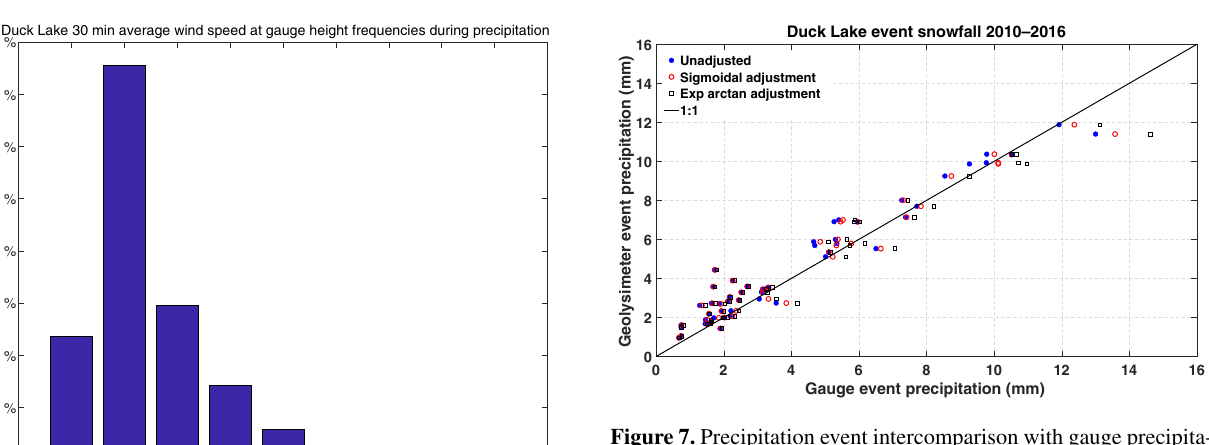
Figure 7. Precipitation event intercomparison with gauge precipita- tion unadjusted and adjusted for wind undercatch using a sigmoidal and an exponential-arctan transfer function as presented in Kochen- dorfer et al. (2017a,